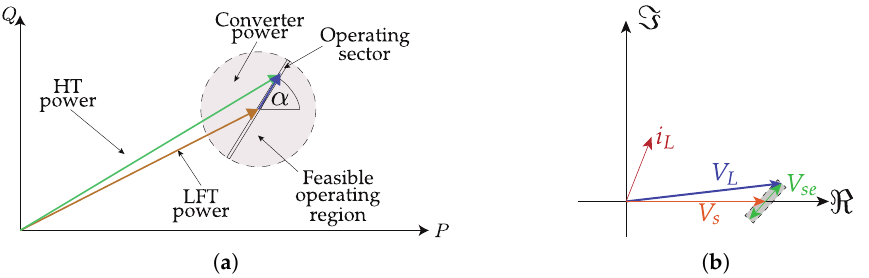
Figure 12. Operating region of HDTs whose power converters are capable to inject restricted active and reactive power. ( a ) PQ operating region. ( b ) Complex plane operating region for voltage